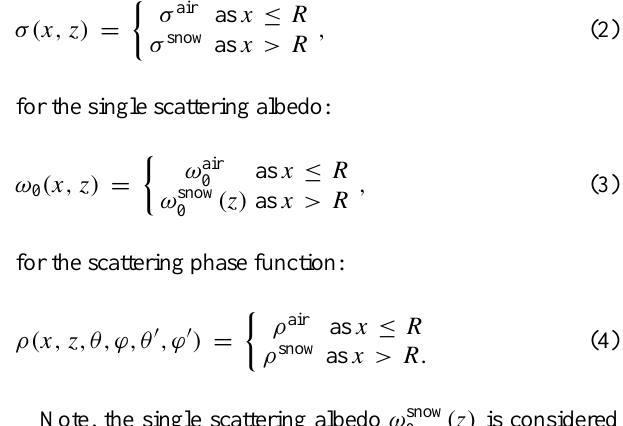
One needs to define the boundary conditions for Eq. (1). The intensity of the radiation entering the region is defined on each boundary at the corresponding angular intervals, see Fig 3. The bottom boundary z = 0 is a Lambertian